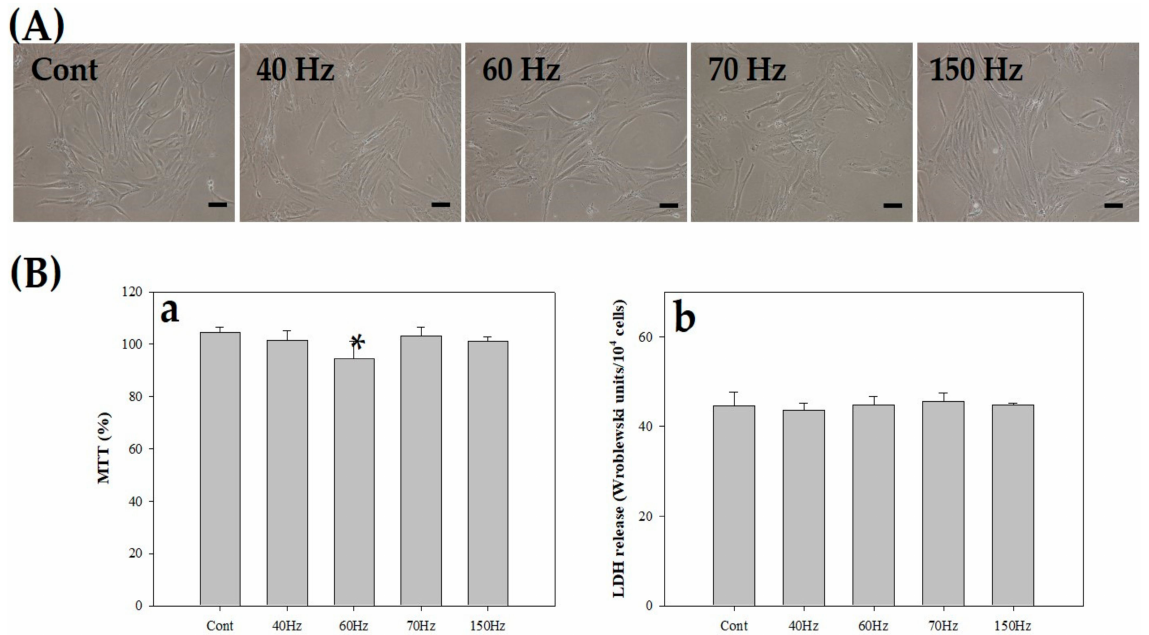
Figure 2. ( A ) Morphologies of human dental pulp stem cells (hDPSCs) after PEMF exposure for 3 days (10 mT). All groups were incubated with the same medium—odontoblastic differentiation medium. Each group had different frequency conditions (40, 60, 70, and 150 Hz). Scale bar = 100 µ m. ( B ) Cell viability ( a ; MTT assay) and stress ( b ; LDH assay) of hDPSCs at 3 days. * p < 0.05 (compared with the control). PEMF; pulsed electromagnetic field; MTT; 3-(3,4-dimethylthiazol-